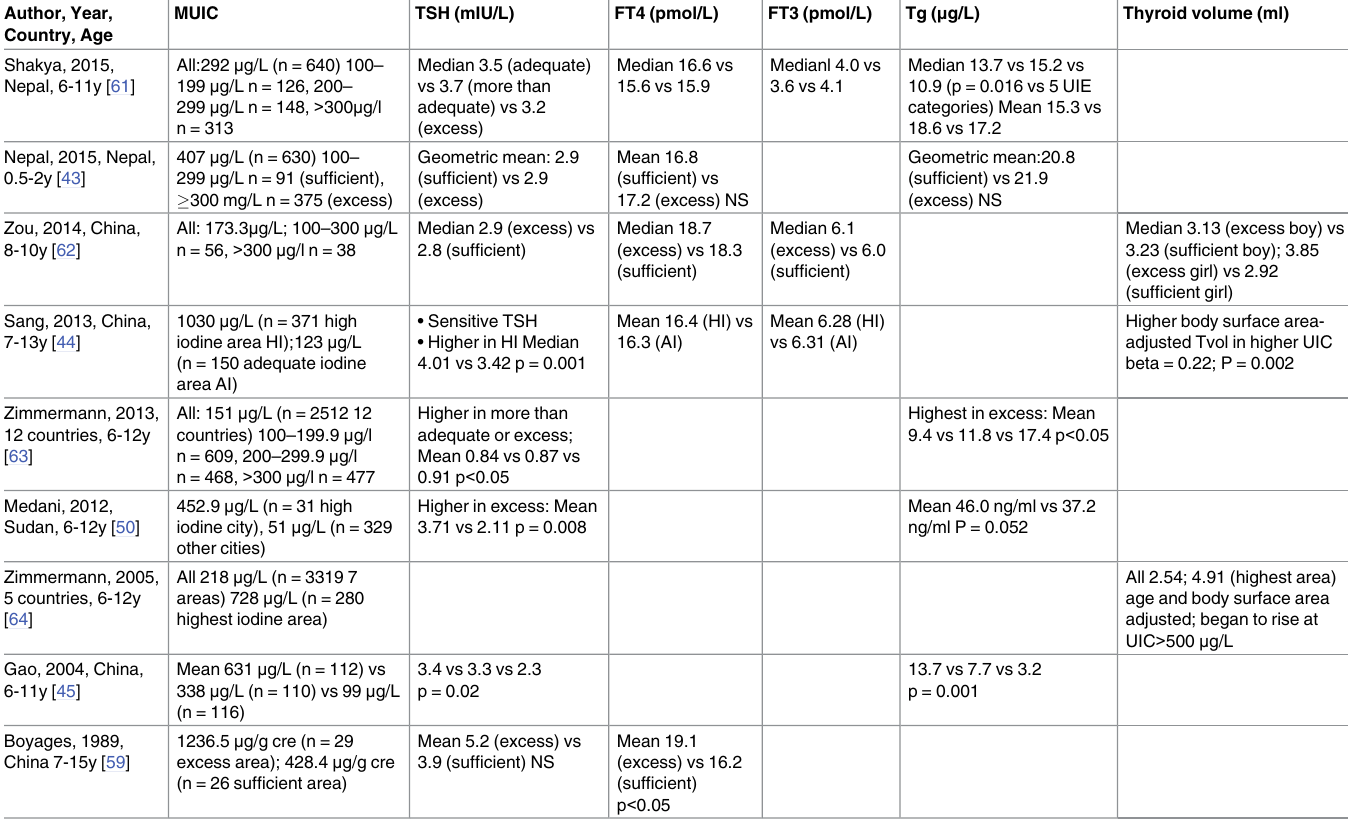
Table 6. Cross-sectional studies including excessmedian urinary iodine in children (outcome: biomarkers for thyroid hormone). Author, Year, MUIC TSH (mIU/L) FT4 (pmol/L) FT3 (pmol/L) Tg ( μ g/L) Thyroid volume (ml) Country, Age Shakya, 2015, Median3.5 (adequate) Nepal, 6-11y [61] vs 3.7 (more than adequate)vs 3.2